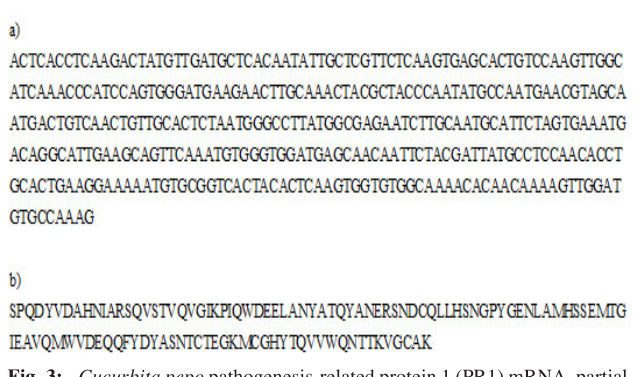
Fig. 3: Cucurbita pepo pathogenesis-related protein 1 (PR1) mRNA, partial cds (a) and partial protein (b).